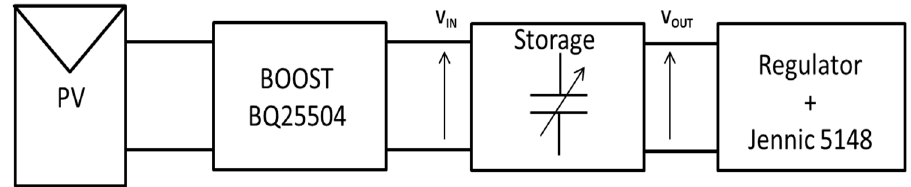
Figure 13. Implementation of the proposed variable storage architecture into a wireless sensor node powered by a photovoltaic cell (PV).